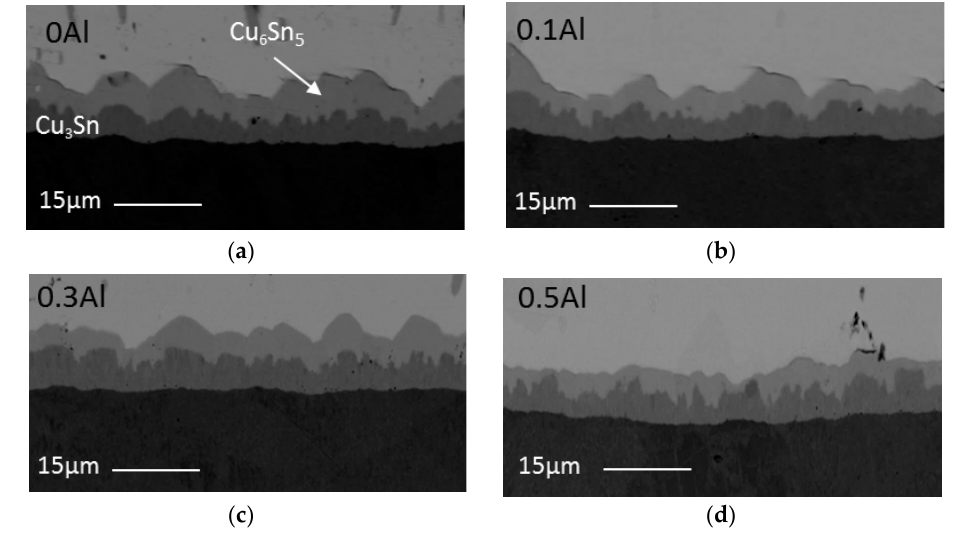
Figure 9. Cross sectional images of: ( a ) SAC105; ( b ) SAC105 + 0.1Al; ( c ) SAC105 + 0.3Al; and ( d ) SAC105 + 0.5Al after aging at 150 °C for 720 h.